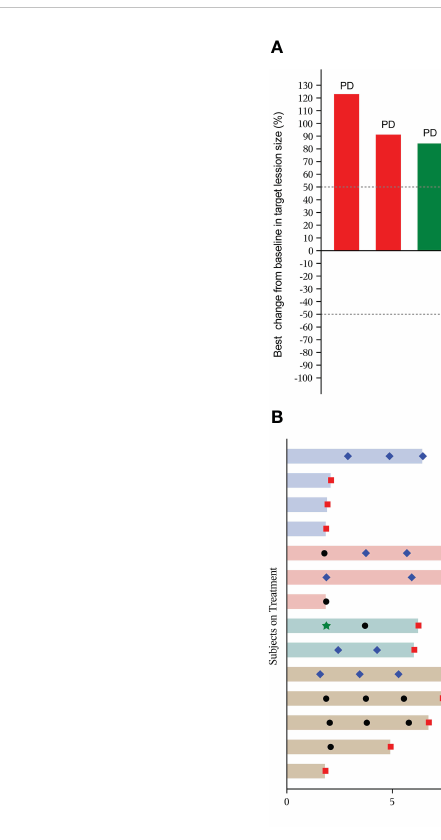
FIGURE 2 Tumor response in evaluable patients (n=14). (A) The best percentage changes from baseline in target lesions; (B) Treatment exposure and response duration. PTCL-NOS, peripheral T-cell lymphoma, not otherwise speci fi ed; NK/T, natural killer/T-cell lymphoma; ALK-ALCL, ALK negative anaplastic large cell lymphoma; AITL, angioimmunoblastic T-cell lymphoma; CR, complete response; PR, partial response; SD, stable disease; PD, progressive